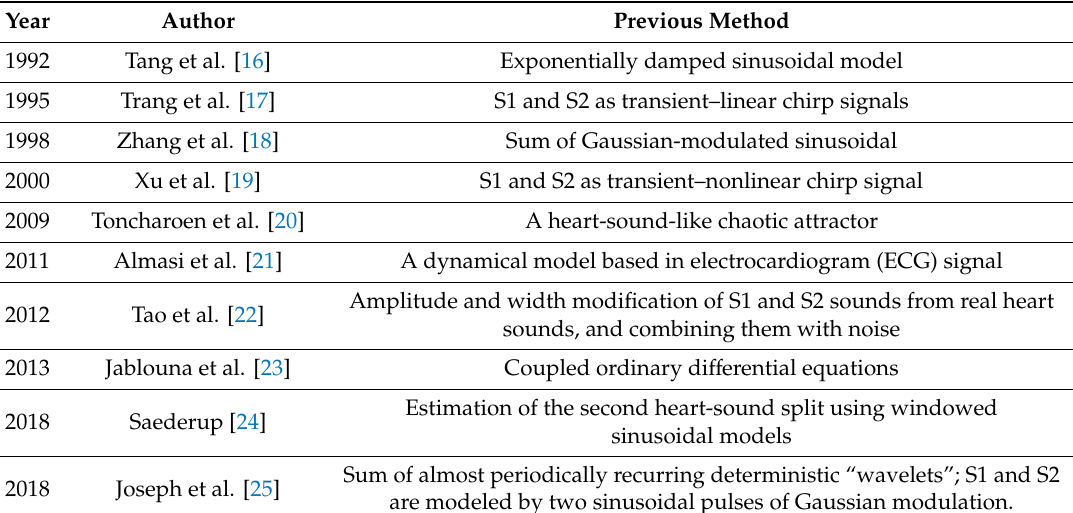
Table 1. Timeline of methods for the generation of synthetic heart sounds.